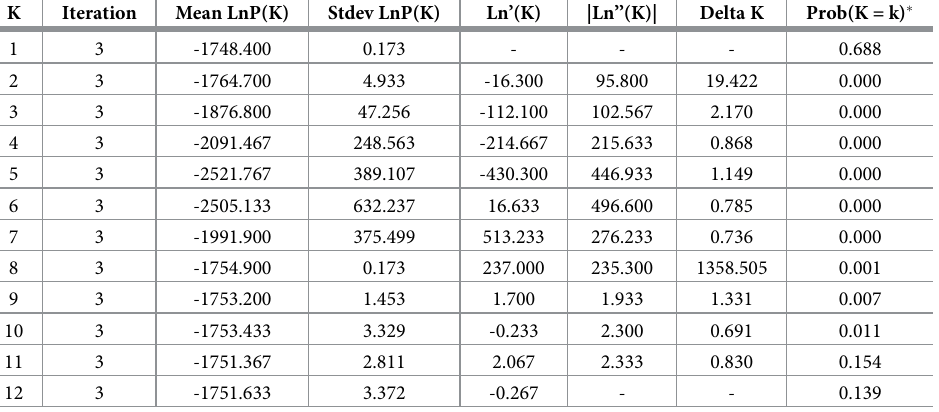
Table 3. Estimates and probabilities of K population structure. Mean LnP (K), Ln’ (K), Ln” (K), and Delta K are given using the Evanno method (see [69] for details). Prob (K = k) is the probability for each K given by STRUCTURE. � computed in